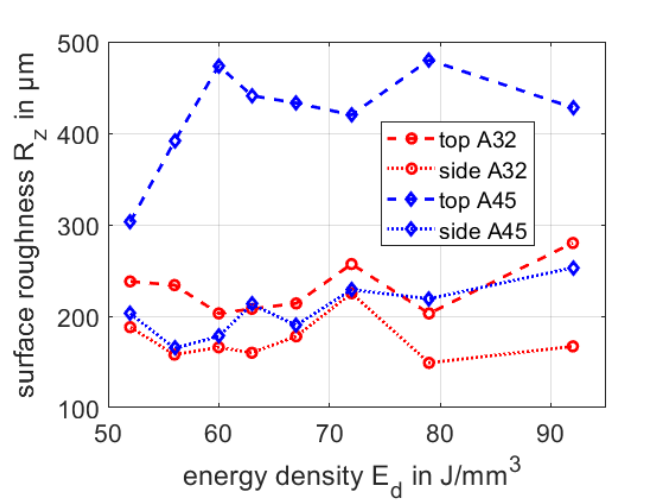
Figure 6. Comparison of surface roughness of the top and side surfaces.